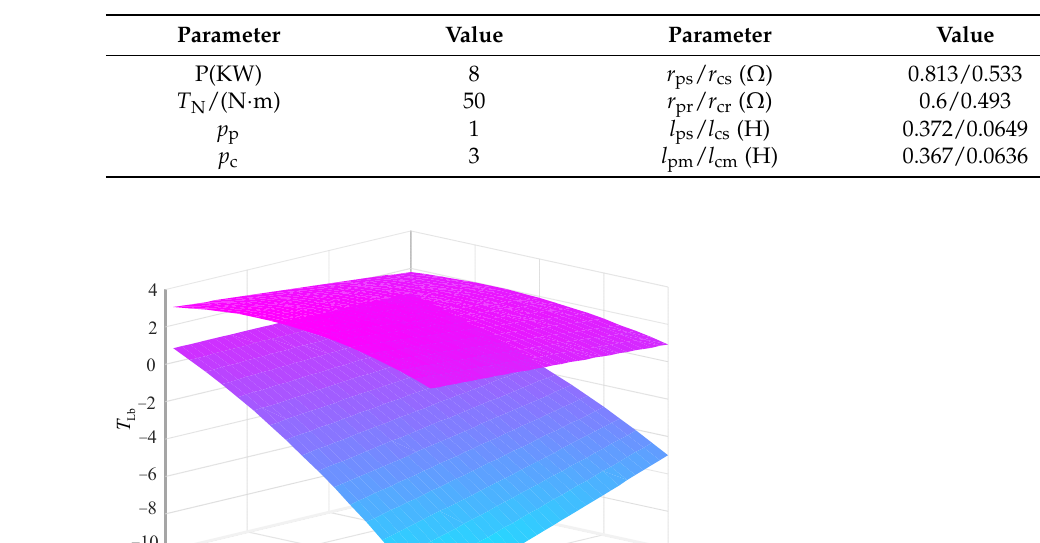
Table 1. BDFM Experimental parameters.